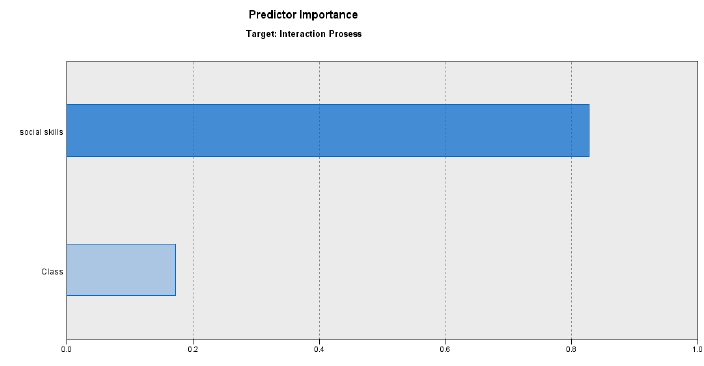
Figure 5. Interaction process (source: created by authors)